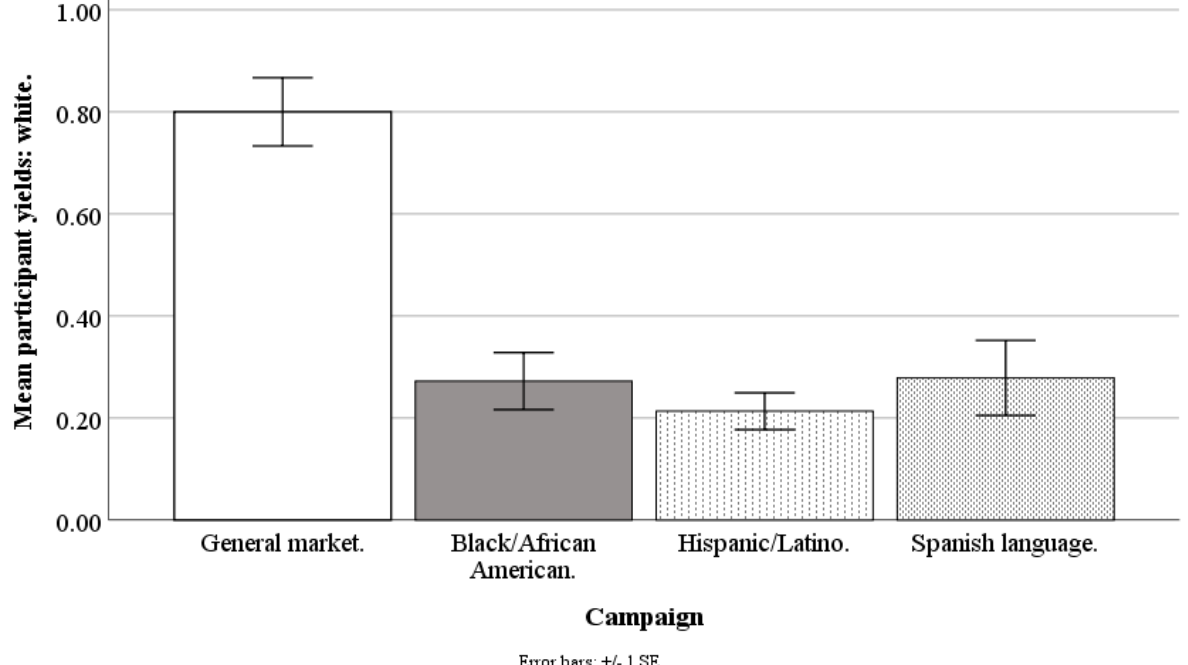
Figure 7. Mean participant yields of whites for Facebook advertising